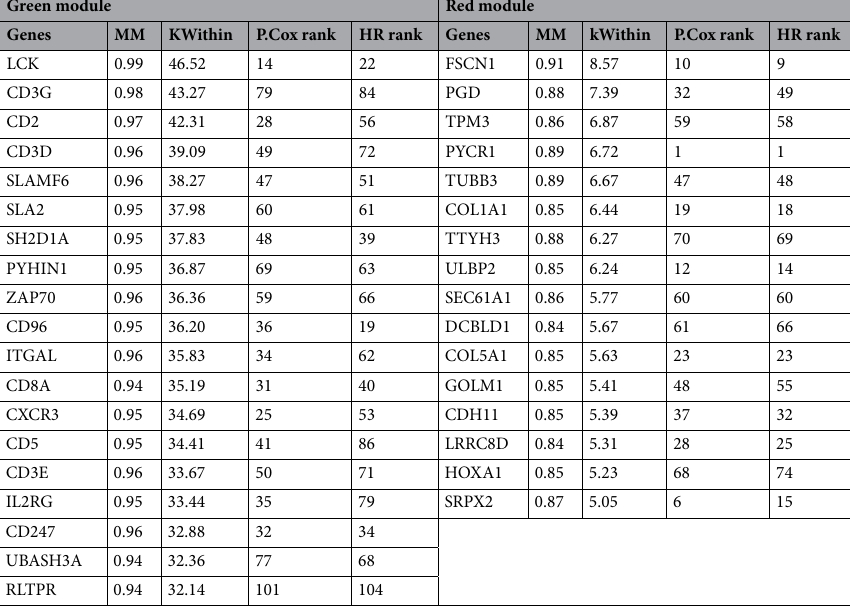
Table 2. Hub genes in green and red modules. P.Cox rank and HR rank are the order of genes; based on P value and hazard ratio resulted from univariate Cox regression in the modules.